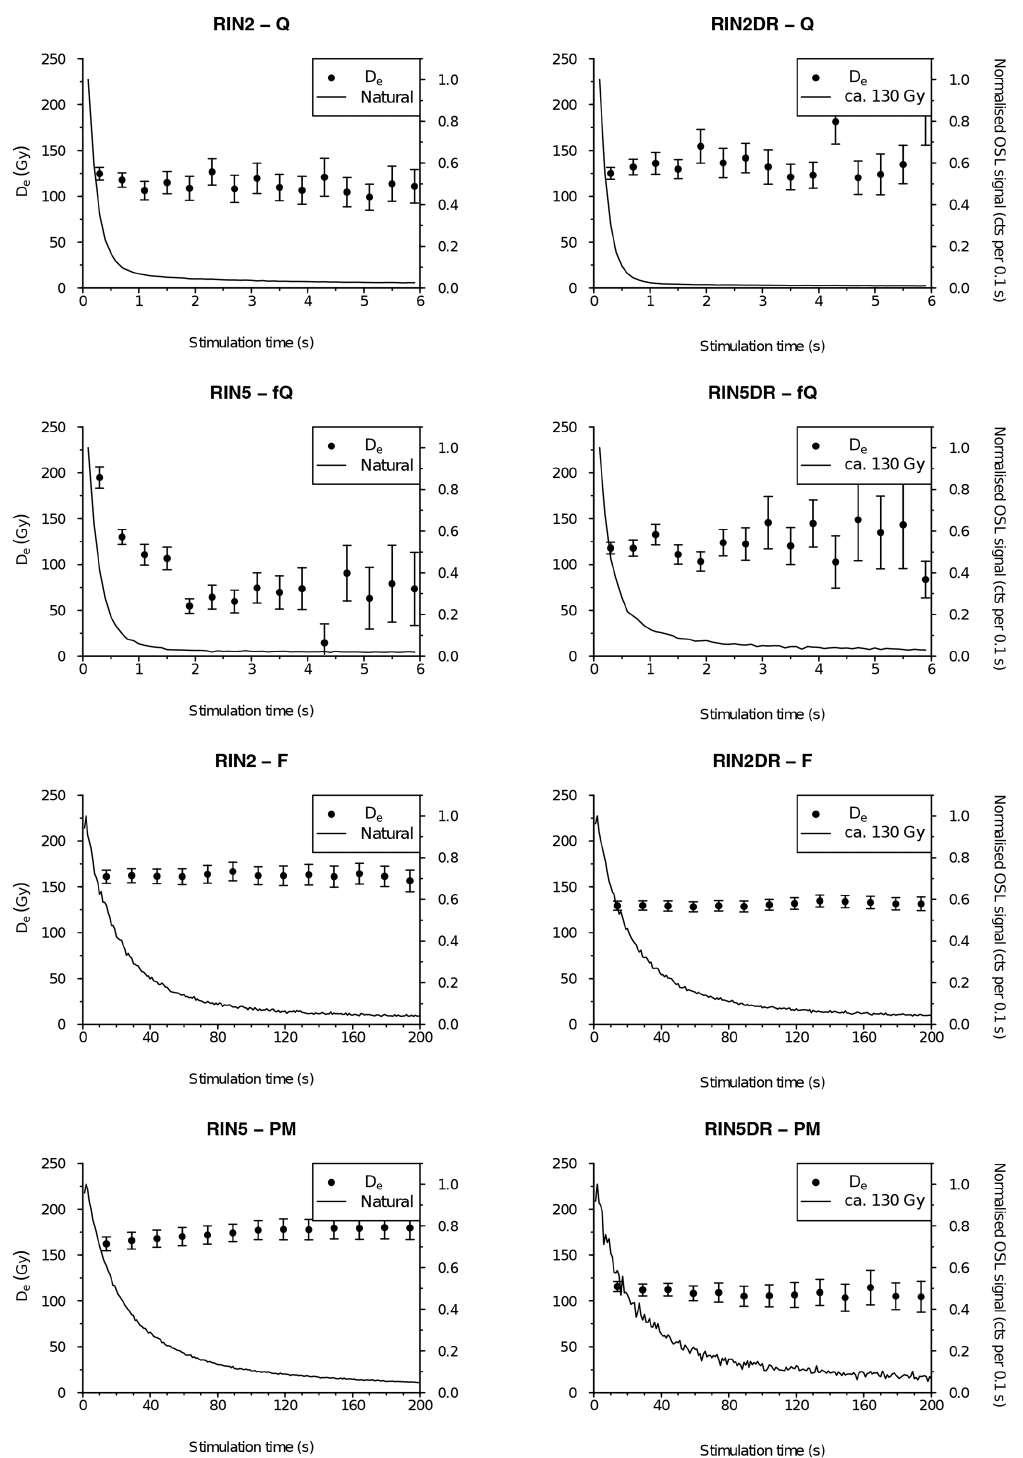
Figure 7. D e ( t ) plots of the natural dose determination and dose recovery (DR) tests for Q and F of RIN2 and f Q and PM of RIN5. D e ( t ) plots were calculated for 0.4s intervals (Q, f Q) and 1.5s (F, PM). The normalised luminescence signals of the natural or first given (DR) dose are